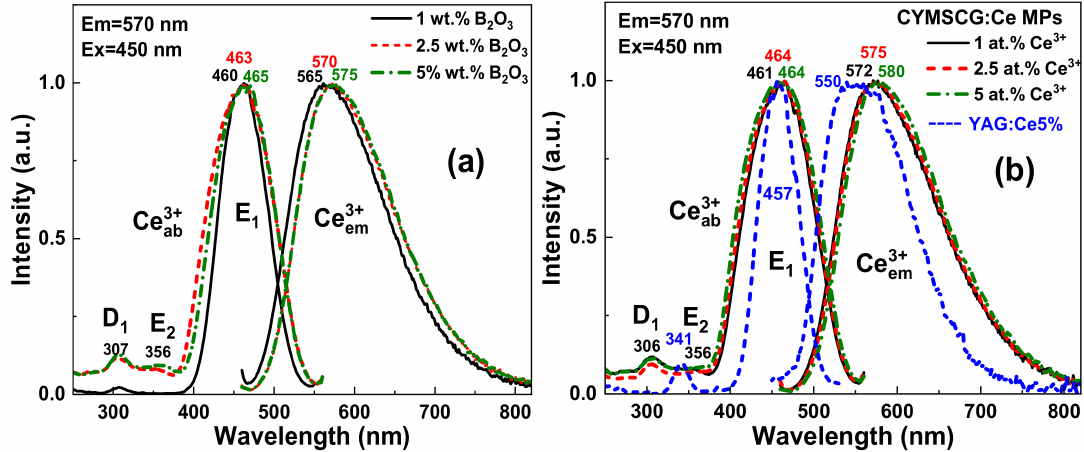
Figure 5. PL spectra and PLE spectra of CYMSSG:Ce (1 at.%) MPs sintered with different amounts of B 2 O 3 flux ( a ) and PL spectra and PLE spectra of CYMSSG:Ce MPs samples with different concentra- tions of Ce 3+ ions sintered with a B 2 O 3 flux content of 2.5 wt.% ( b